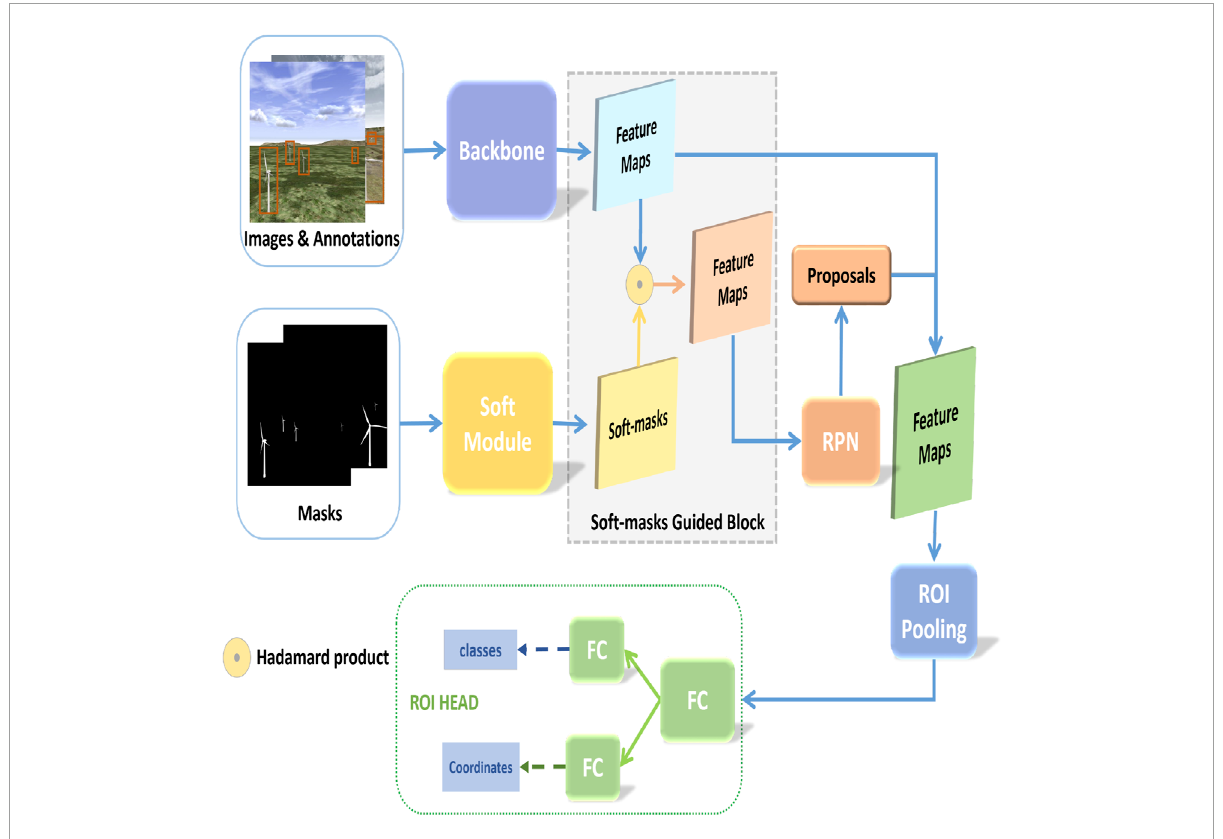
FIGURE 4 The architecture of SMG Faster